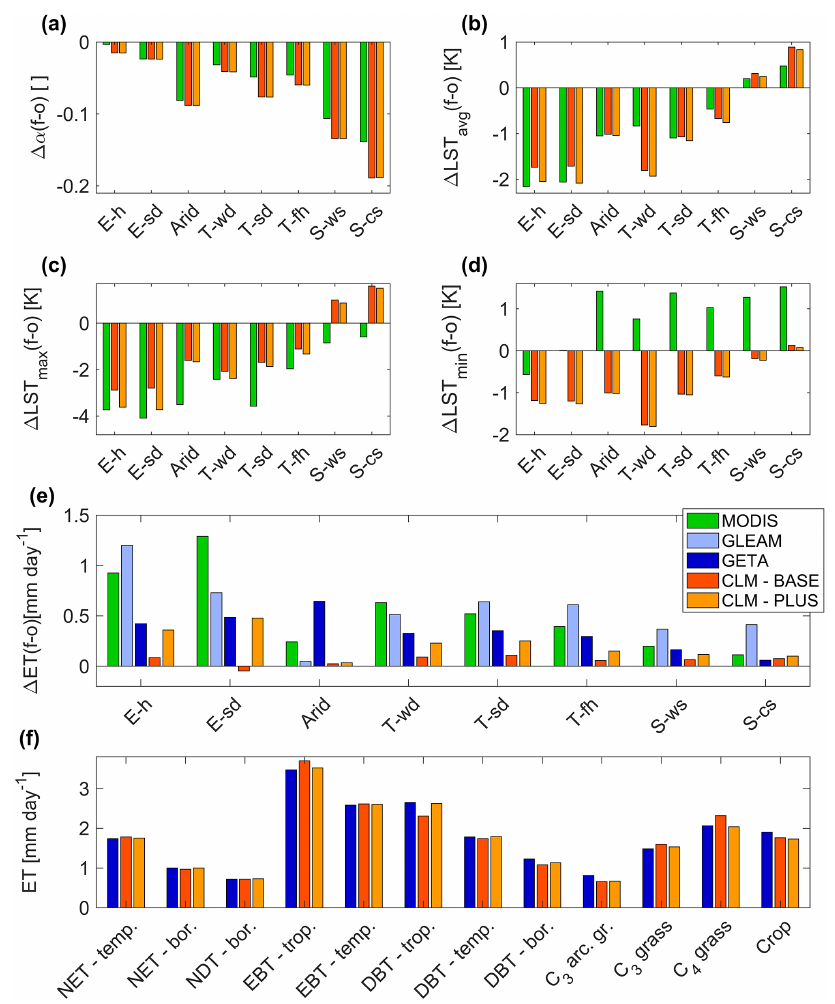
Figure 3. Area-weighted annual mean over Köppen–Geiger climate zones (Kottek et al., 2006, Fig. 1) of (a) (cid:49)α(f − o) , (b) (cid:49) LST avg (f − o) , (c) (cid:49) LST max (f − o) , and (d) (cid:49) LST min (f − o) in MODIS (green), CLM-BASE (red), and CLM-PLUS (orange). Only grid cells containing valid data in the MODIS observations were considered for analysis of CLM4.5. Panel (e) shows the area-weighted mean over the Köppen– Geiger climate zones of (cid:49) ET (f − o) in MODIS (green), GLEAM (light blue), GETA (dark blue), CLM-BASE (red), and CLM-PLUS (orange), and (f) the area-weighted mean ET for each PFT analyzed in this study according to the GETA (dark blue), CLM-BASE (red), and CLM-PLUS (orange). The acronyms of the PFTs are defined in Table